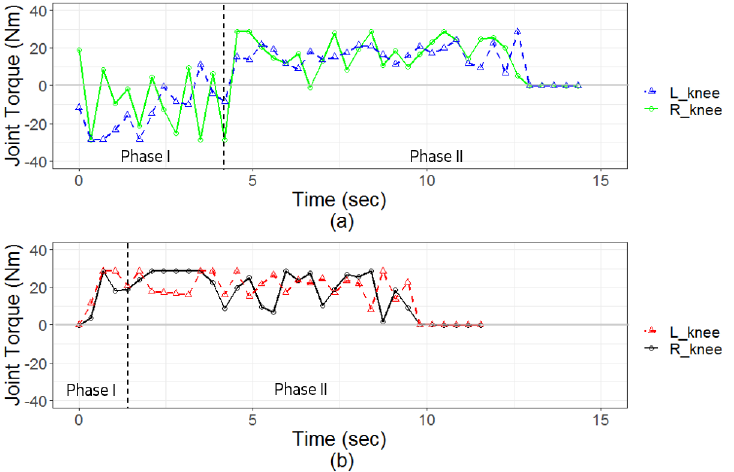
Figure 15. Joint torque measured from the knee joint using the correct ( a ) and incorrect ( b ) methods of standing assistance.